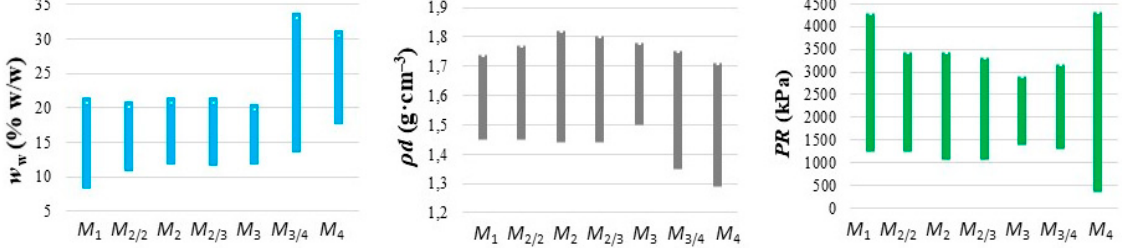
Figure 6. The ranges of changes in the values of the independent ( w w , ρ d ) and the dependent ( PR ) variables for individual subsets of data ( M x ), obtained after soil grouping with combination number 9 (see also Table 5).